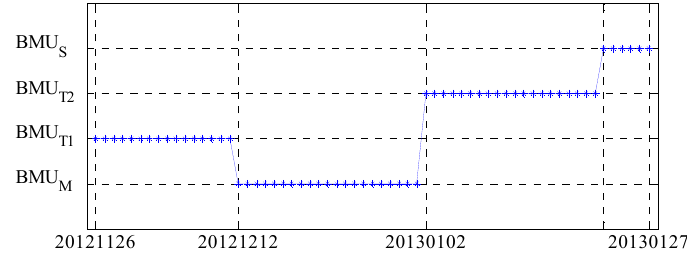
Figure 12. The BMU time series from November 26, 2012 to January 27, 2013.